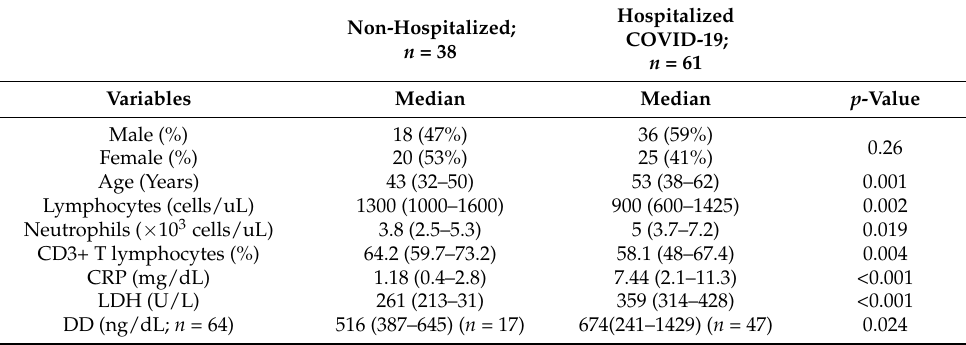
Table 2. Population characteristics in non-hospitalized and hospitalized COVID-19